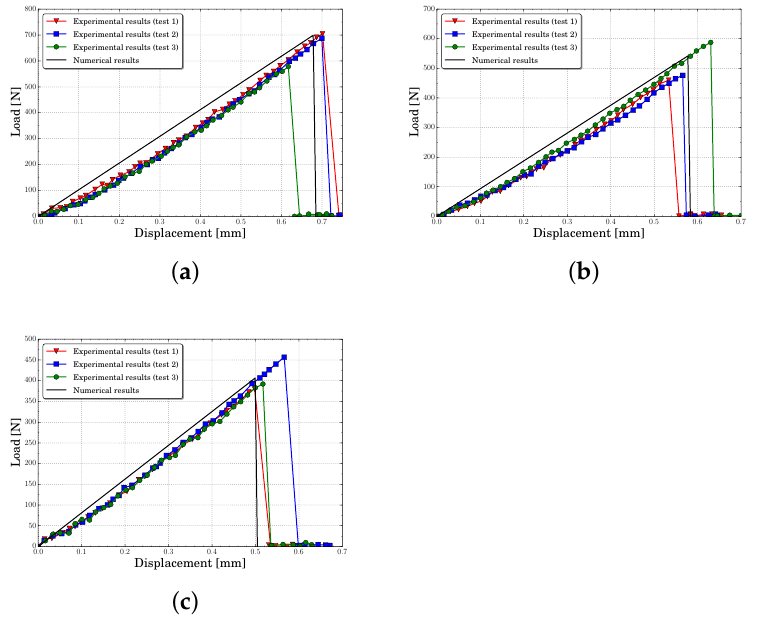
Figure 12. Load-displacement curves for a notch eccentricity of d = 20 mm predicted for different notch lengths a ( a ) a = 6 mm, ( b ) a = 8 mm, ( c ) a = 10